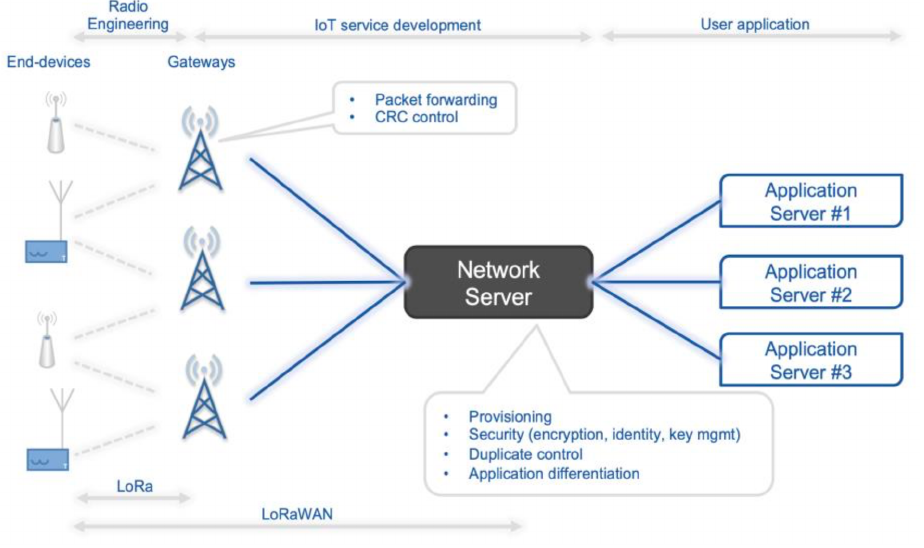
Figure 2. LoRaWAN simplified